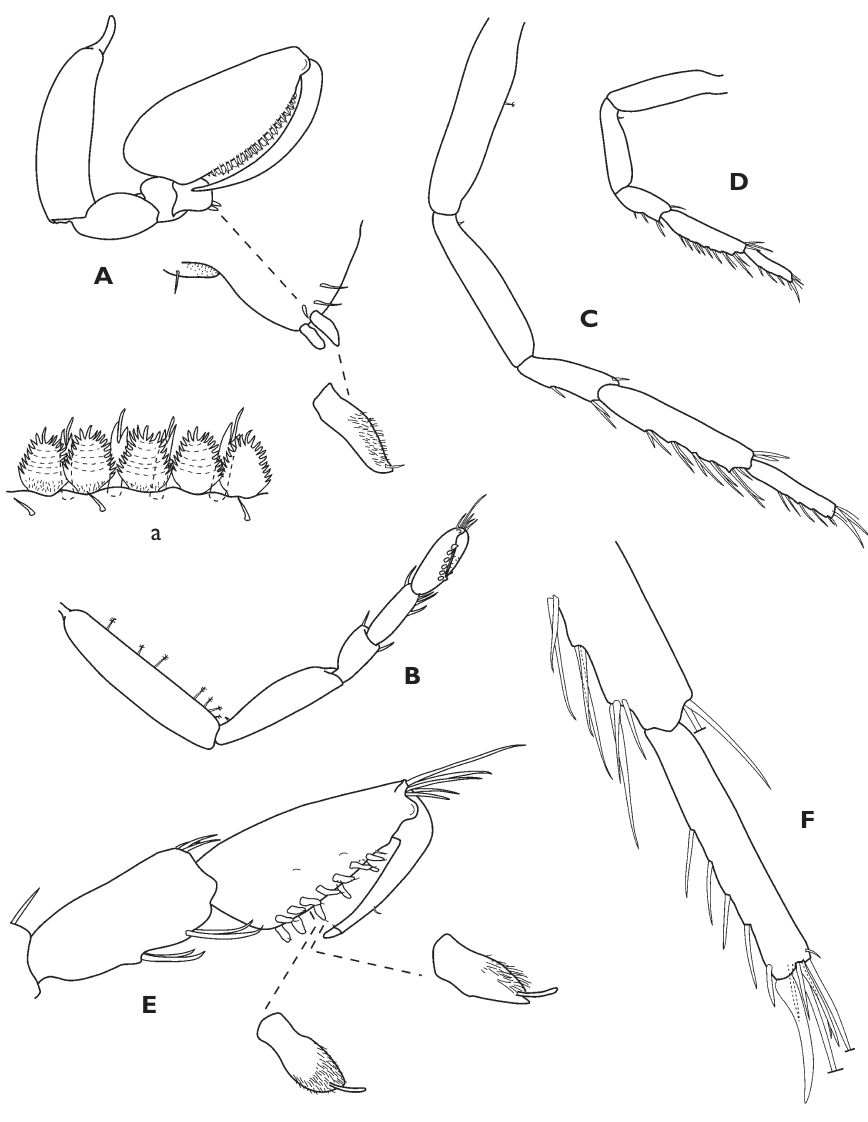
Figure 3. Heteroserolis pellucida sp. n. Paratype ♂ 10.5 mm, Is.6017. A–D pereopods 1, 2, 6 and 7 respectively; a, detail of pereopod 1 propodal palm setae E pereopod 2 distal articles F pereopod 6, distal